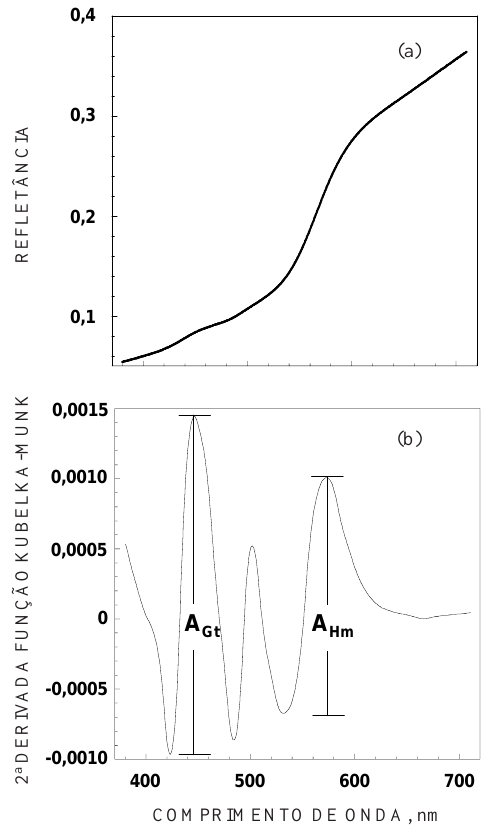
Figura 1. Espectro de refletância difusa (a) e correspondente segunda derivada da função Kubelka-Munk (b), com a indicação da medida da amplitude (A) atribuída à goethita (A hematita (A Hm